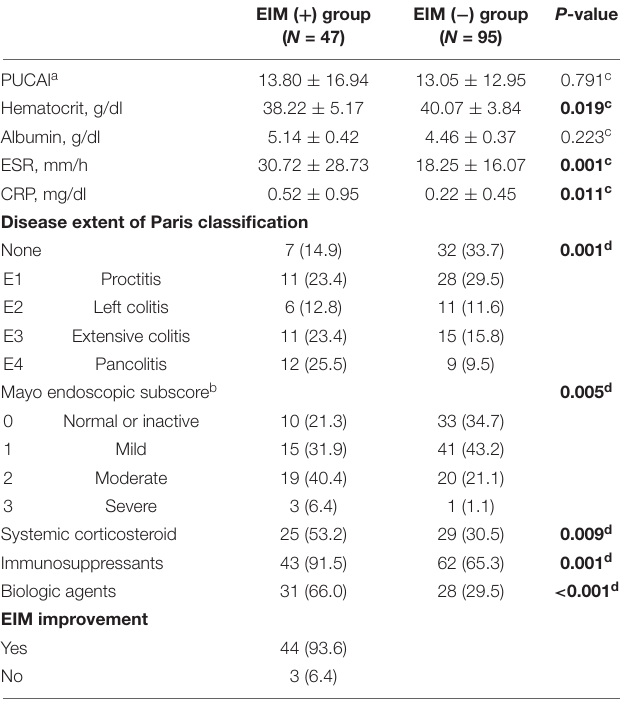
TABLE 3 | Demographic and clinical features of the two groups 1 year after the diagnosis; patients in EIM ( + ) group have extraintestinal manifestations with intestinal symptoms and patients in EIM ( − ) group only express intestinal